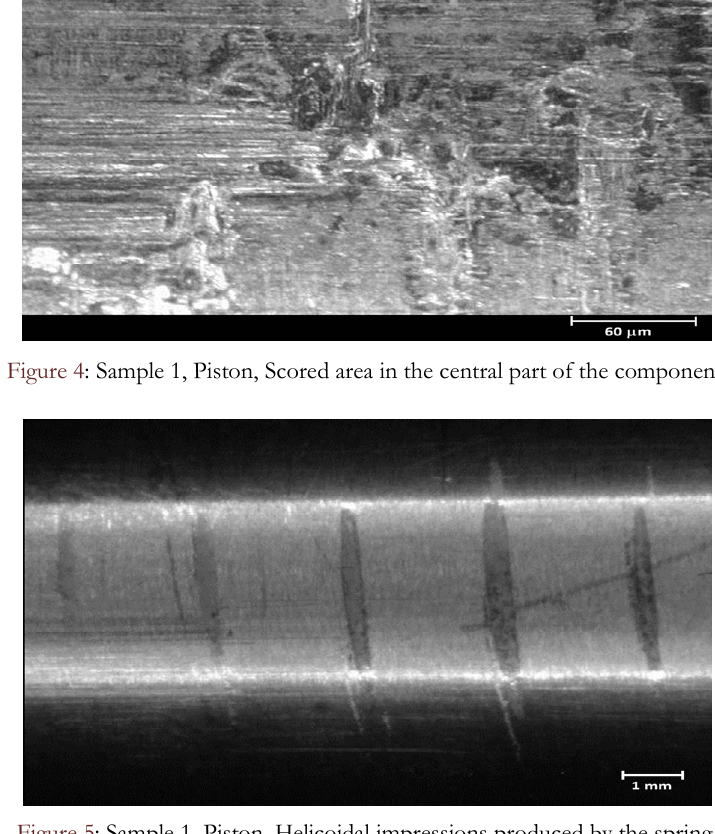
Figure 5: Sample 1, Piston, Helicoidal impressions produced by the